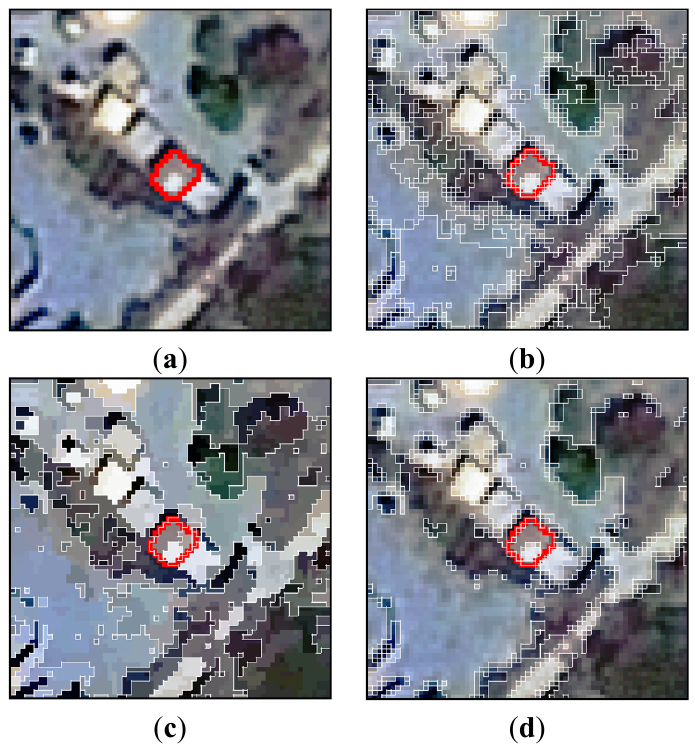
Figure 2. An image subset ( a ) segmented with ( (cid:2009) w -CC) to show its common characteristics on real imagery, with the local and global range parameters set to 25 and 75 ( b ), 25 and 75 with a region growing filter ( c ), and to 50 and 200 ( d ), respectively. The red polyline indicates an example element a user might be interested